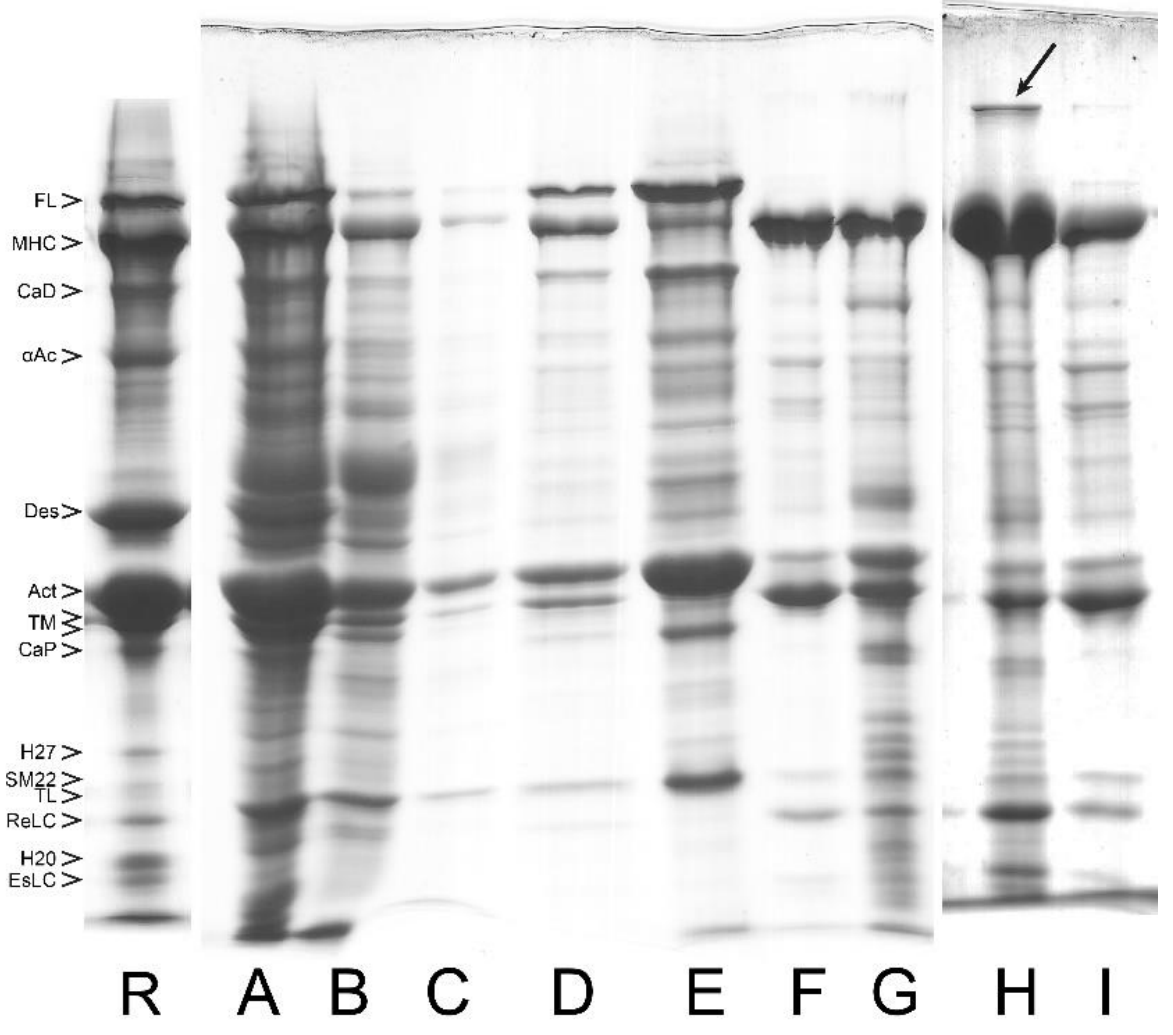
Figure 5. Purification steps of bovine tracheal smooth muscle myosin analyzed by SDS PAGE system for a very small amount of starting muscle tissue (about 1 g). Individual bands are identified and labeled with abbreviated names. (R) Reference lane taken from the right lane of Figure 2. ( A ) Whole bovine tracheal smooth muscle homogenized in BW with Polytron in a 2 mL Eppendorf tube. ( B ) Supernatant of the first wash. ( C ) Second wash. ( D ) LAMES extract (crude actomyosin). ( E ) Thin filament fraction of crude actomyosin (40% am.sulf. pellet). ( F ) CMY (40 – 57% am.sulf. pellet of crude actomyosin). ( G ) Myosin pellet (CMY dialyzed o/n against BW). ( H ) Subsequent pellet after freezing in LN . The black arrow at the top of the lane indicates smitin, which co-purifies with myosin to 2